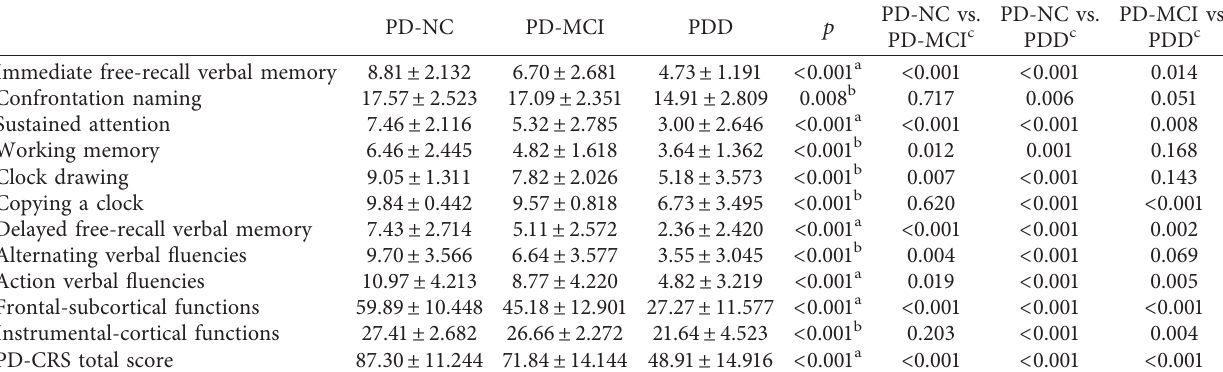
Table 5: Comparisons of PD-CRS between PD-NC, PD-MCI, and PDD